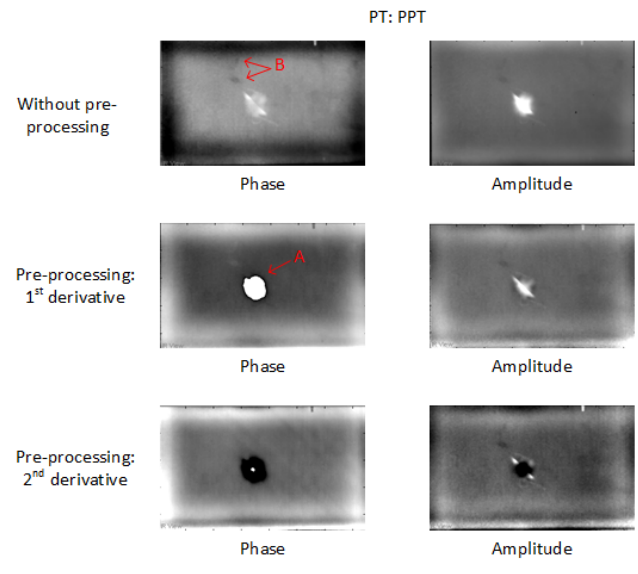
Figure 6. PPT results in PT for CFRP